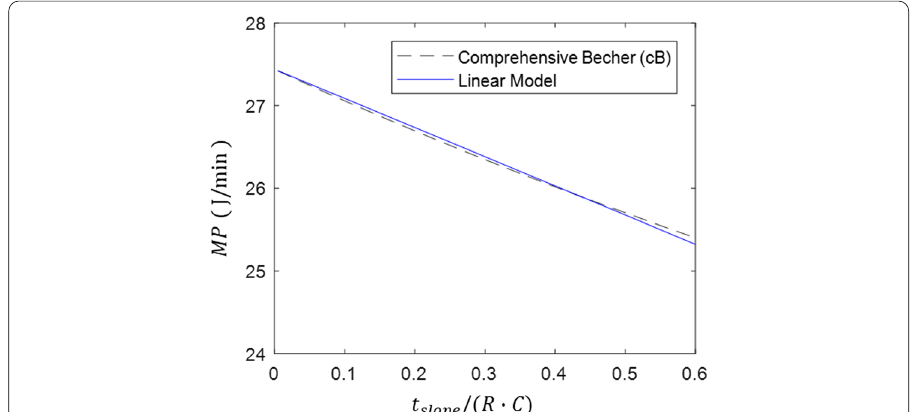
Fig. 5 Comparison of mechanical power predicted by the comprehensive Becher, et al. equation and the linear model derived here. The two equations show excellent agreement over a realistic range of t slope /( RC )